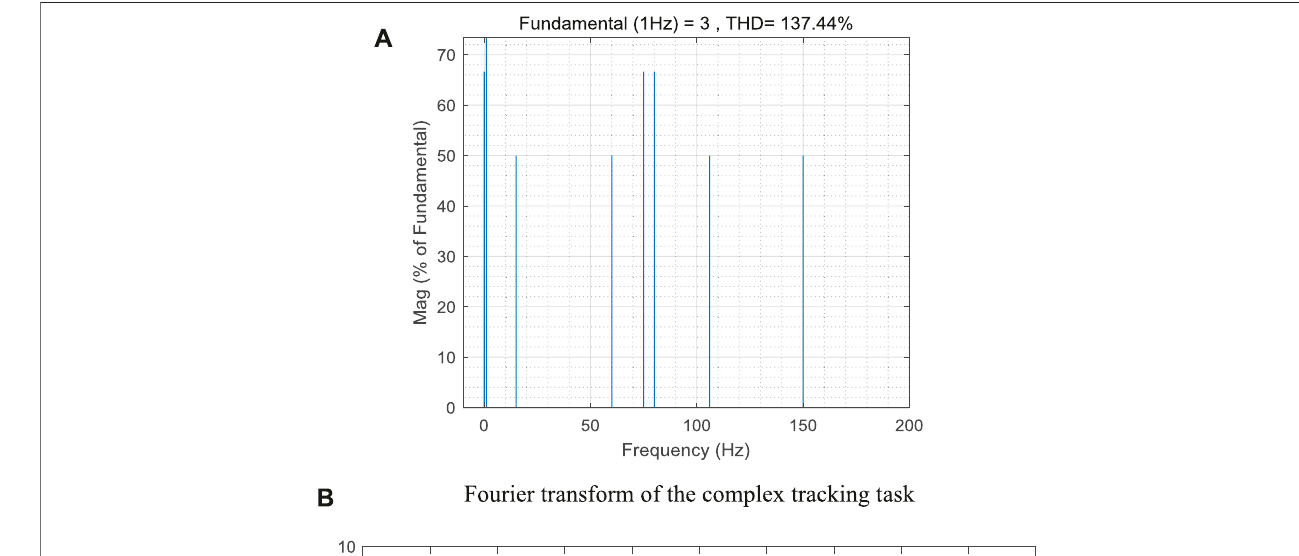
FIGURE7| Trackingcontrolresultofthehybridcontrolmethodwiththecomplextrackingtask: (A) Fouriertransformoftheconmplextrackingtask, (B) X-axis,and (C) Y-axis.